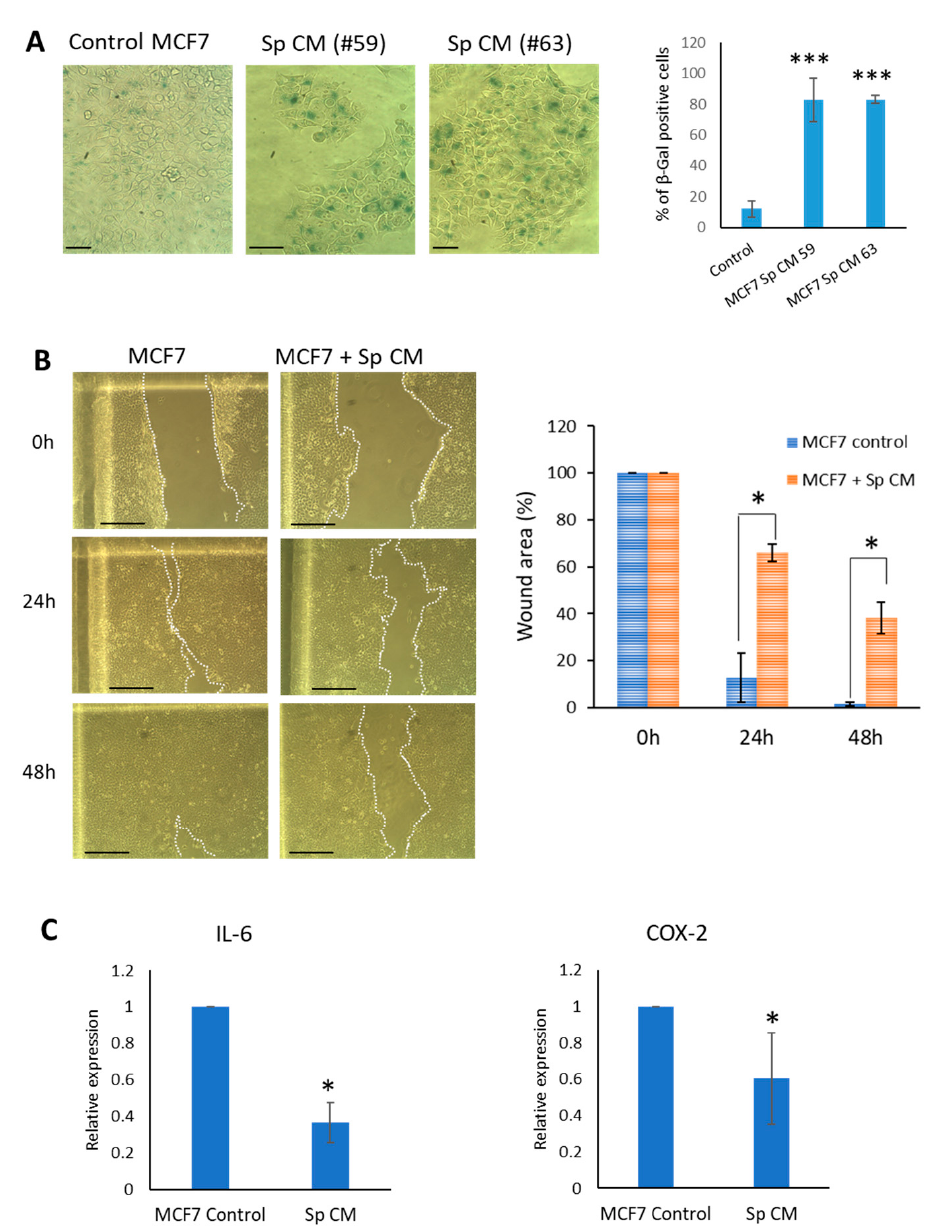
Figure 8. Influence of Spalax CM on the level of SA- β -Gal activity, migration and expression of SASP factors in MCF-7 breast cancer cells ( A ) SA- β -Gal staining representative images. MCF-7 cells were treated with Spalax CMs for 4 days. The percentage of SA- β -Gal-positive cells calculated from at least 300 cells in four independent fields for each biological repeat (n = 2) in triplicate ( Spalax CMs were collected from senescent cells of two independent individuals (#59 and #63). Data presented as mean ± SD. *** p < 0.001; differences between control MCF-7 cells (untreated) and treated with Spalax CMs; ( B ) Scratch assay. Representative images of wound healing in MCF-7 cells untreated or treated with Spalax (Sp) CM. Cell monolayers were scratched with sterile pipette tip to form wounds. The scratch wounds were monitored after 24 and 48 hrs. ( B ) Percentages of cell free area were calculated and are presented as mean ± SD of two independent experiments (n = 2), * p ≤ 0.05 differences between wound area of MCF-7 cells exposed to Spalax CM and control at 24 h/48 h. ( C ) The expression of SASP genes IL-6 and Cox-2 in MCF-7 cells after exposure to Spalax CM. The mRNA expression rates were quantified by using qRT-PCR. Data presented as mean ± SD. * p < 0.05; differences between control cells (untreated) and treated with Spalax CM.